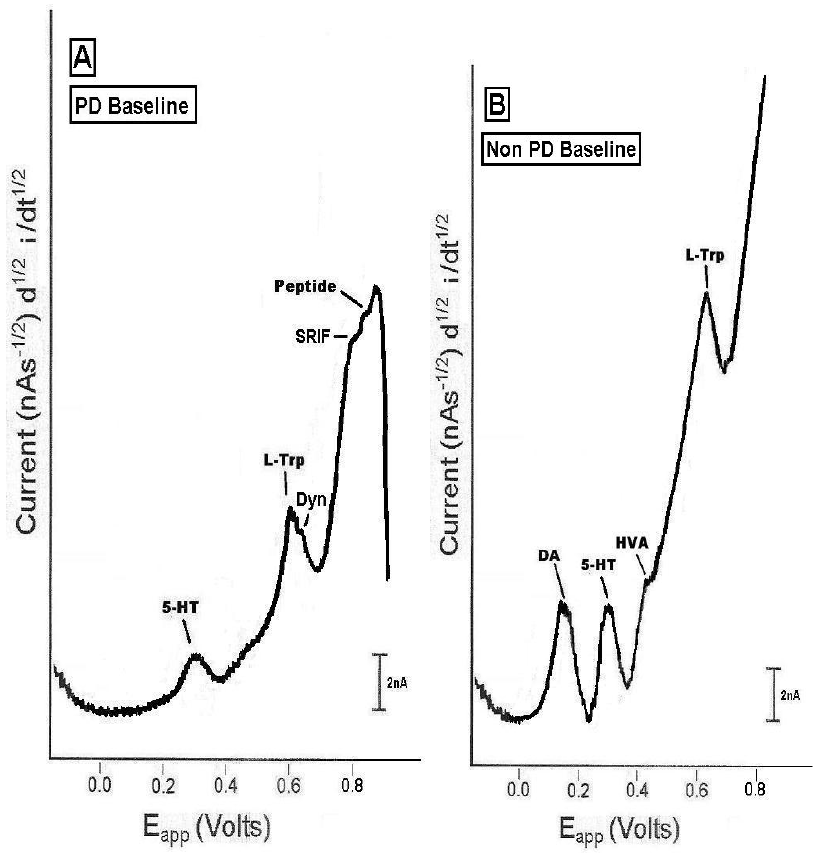
Figure 2. Representative NMI endogenous (baseline, control) neurochemical signature profiles in dorsal striatum of (left) the PD and (right) the non-PD animal in vivo , on line and in real time. Neurochemical profiles are drawn from original